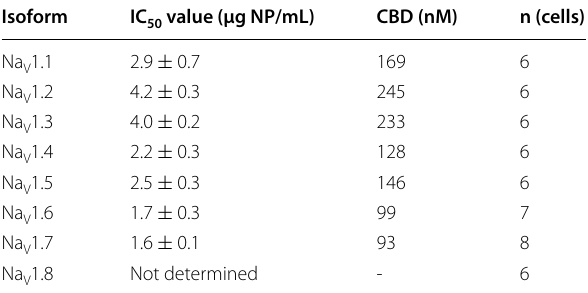
Table 1 IC equivalent molar IC